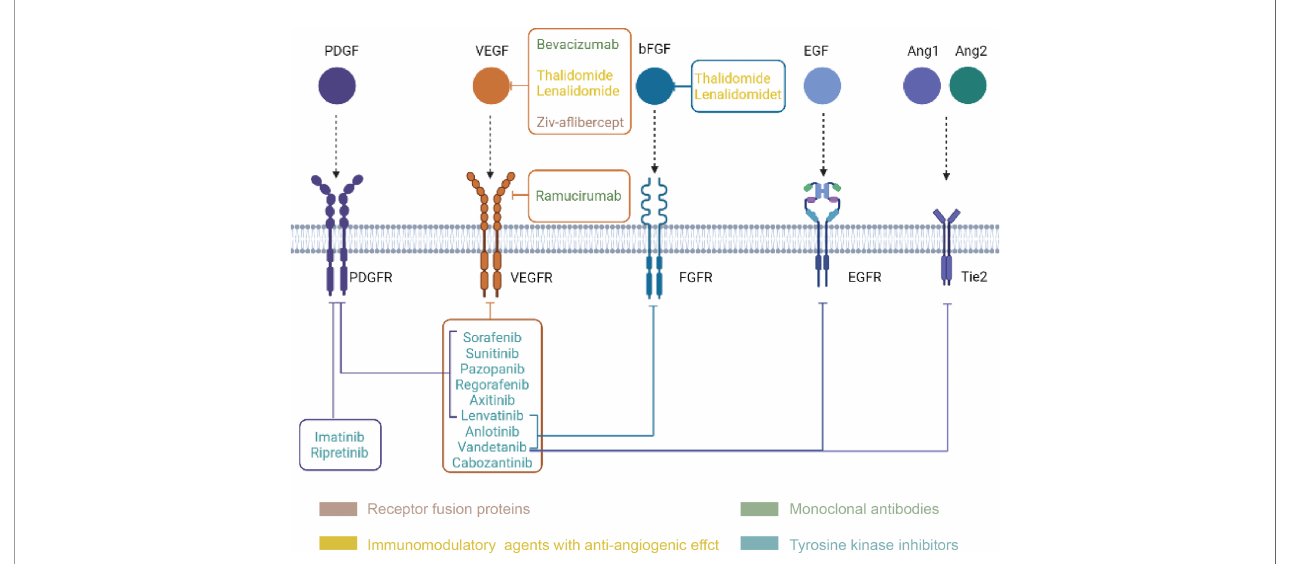
FIGURE 3 | Classi fi cation and targets of anti-angiogenic drugs (Created in BioRender.com). Every drug in the picture points to its own targets, and the four drug types are distinguished by four